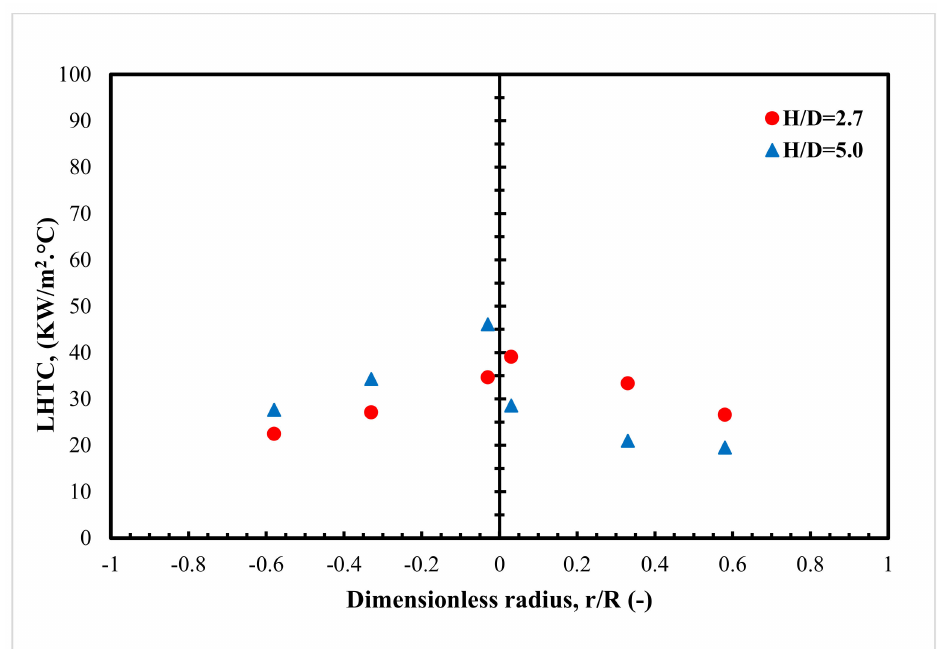
Figure 14. LHTC profiles measured at the different axial levels of 35 and 70 cm and under an operating gas velocity of 0.25 m/s.